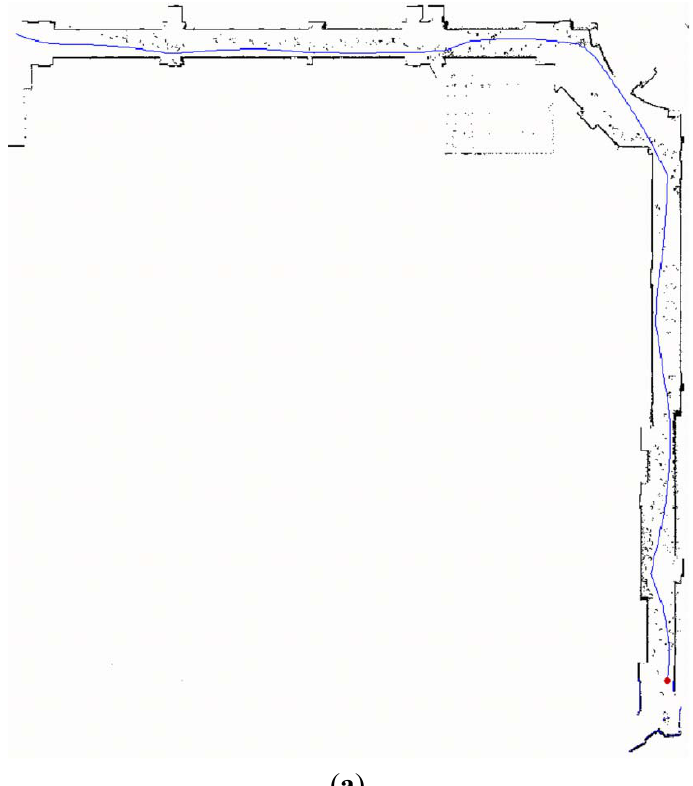
Figure 5. The laser SLAM results with the feature fusion. ( a ) The robot trajectory and the grid map plotted by the software of ActivMedia Co. using raw laser data; ( b ) The final built map using feature fusion where the part circled by the ellipse is enlarged to show the details. orange: the segment map after fusion; light gray: the grid map for